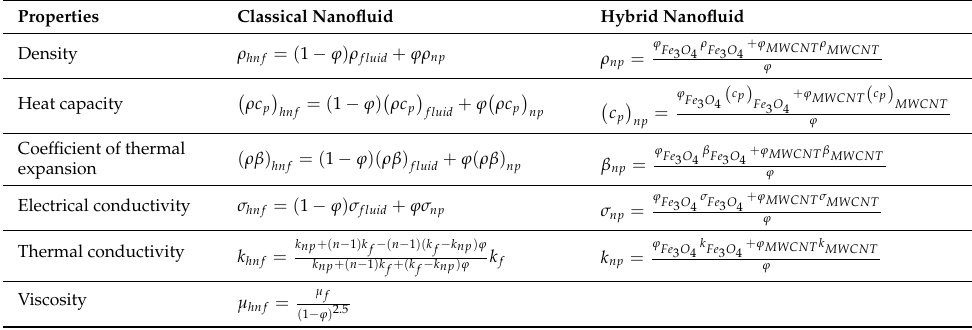
Table 2. Properties of nanofluids and hybrid nanofluids. Properties Classical